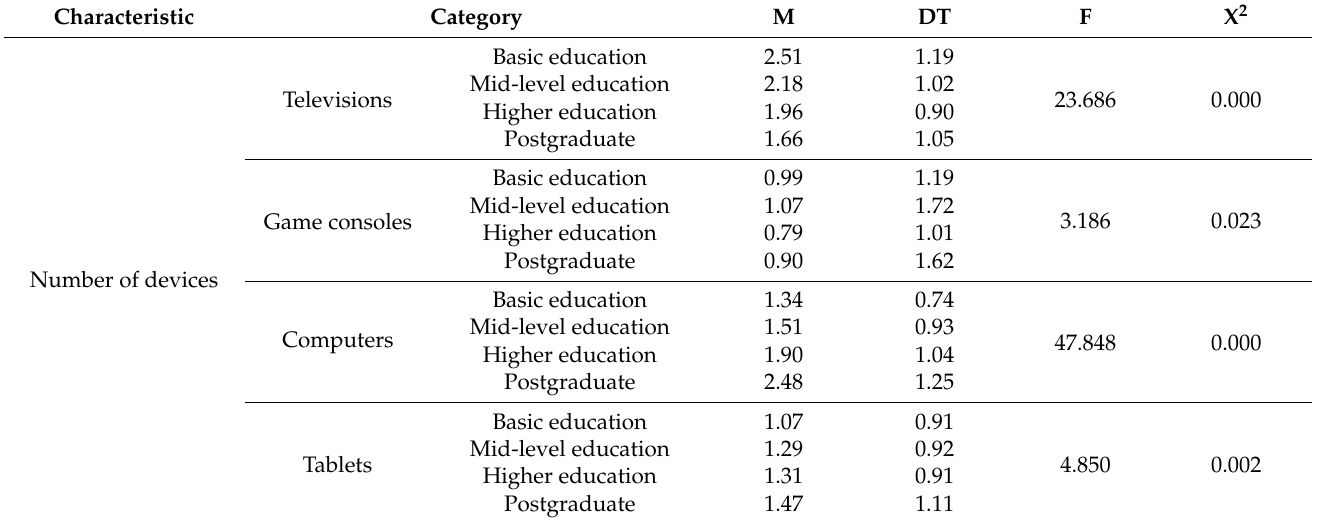
Table 5. Number of devices according to the educational level of European parents.